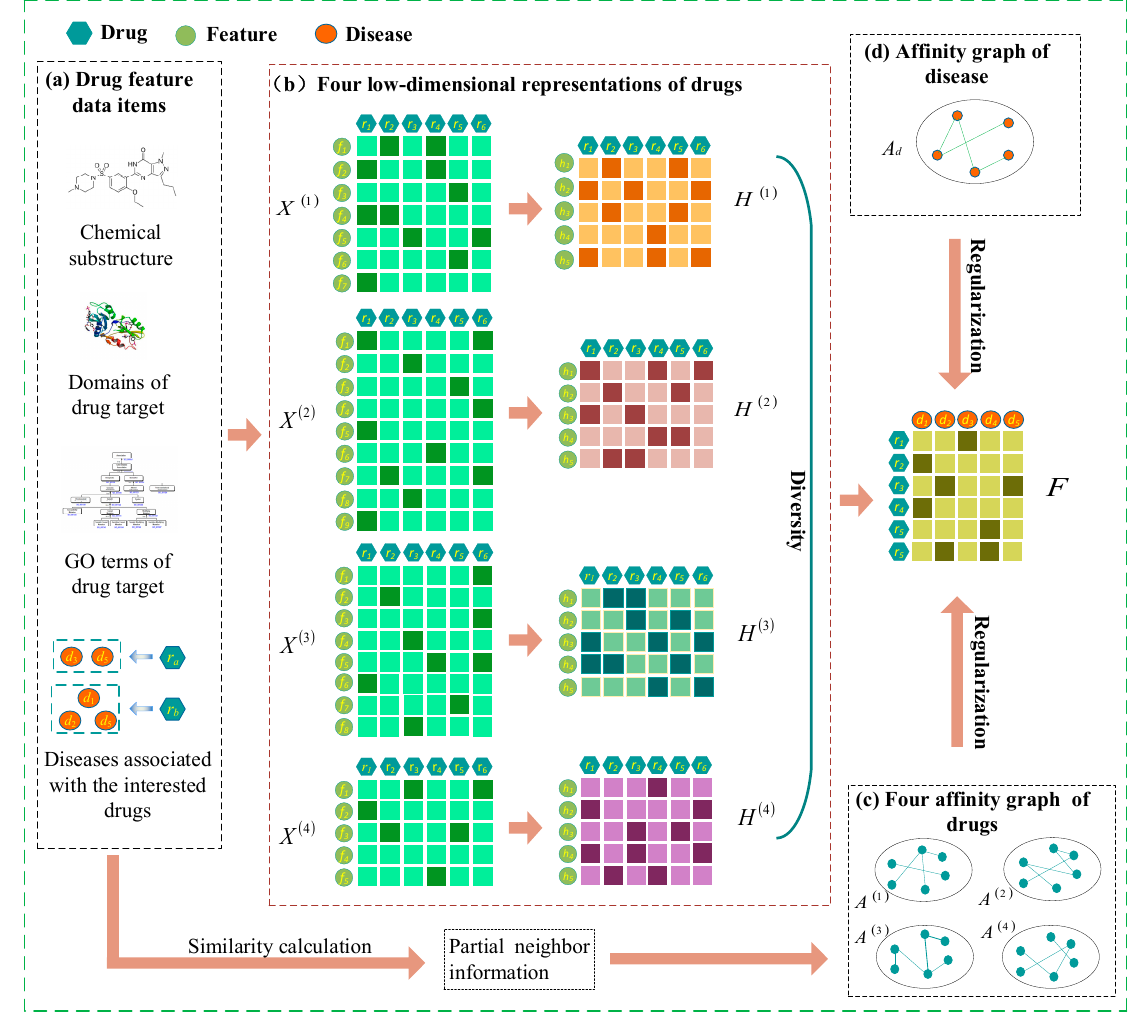
Figure 3. Representation of data from drugs and diseases from multiple sources and representation of drug–disease predictive association matrix F . ( a ) Drug feature data sets from multiple sources; ( b ) four low-dimensional representation of drugs; ( c ) four a ffi nity maps of the drugs were obtained by similarity calculation; ( d ) extract the similarity of the diseases and obtain the a ffi nity map of the